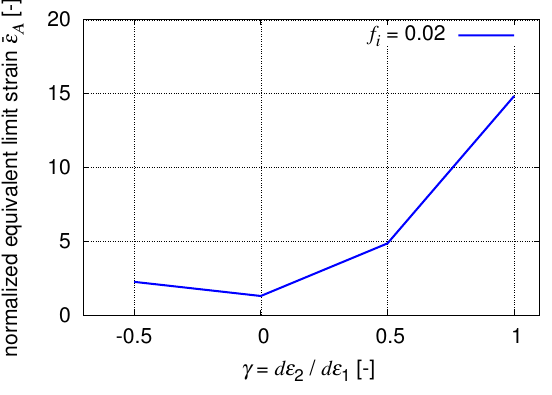
Figure 6. Forming limit curves (FLC)—major strain vs minor strain (strain normalized with respect to the mean uniform strain).